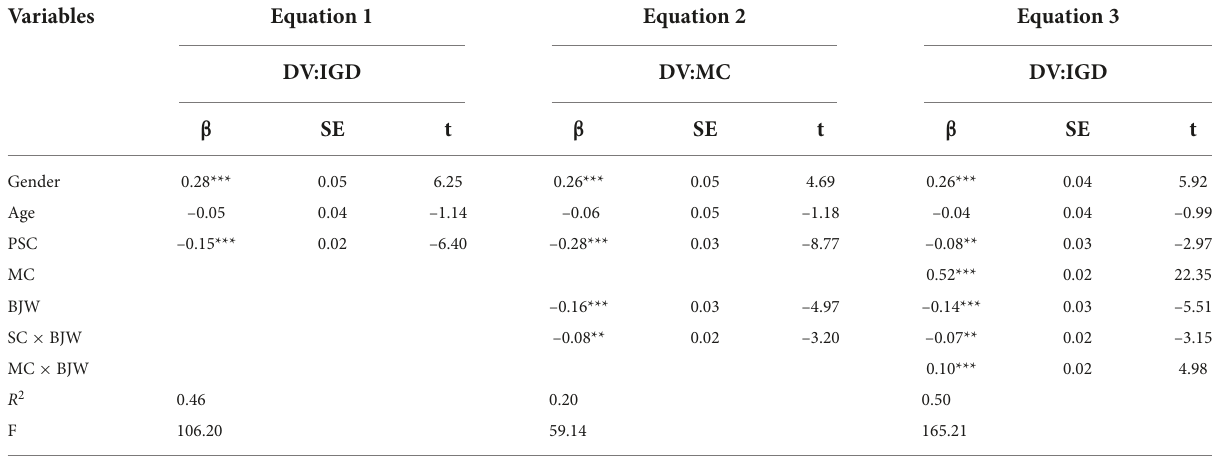
TABLE 4 Testing for moderated